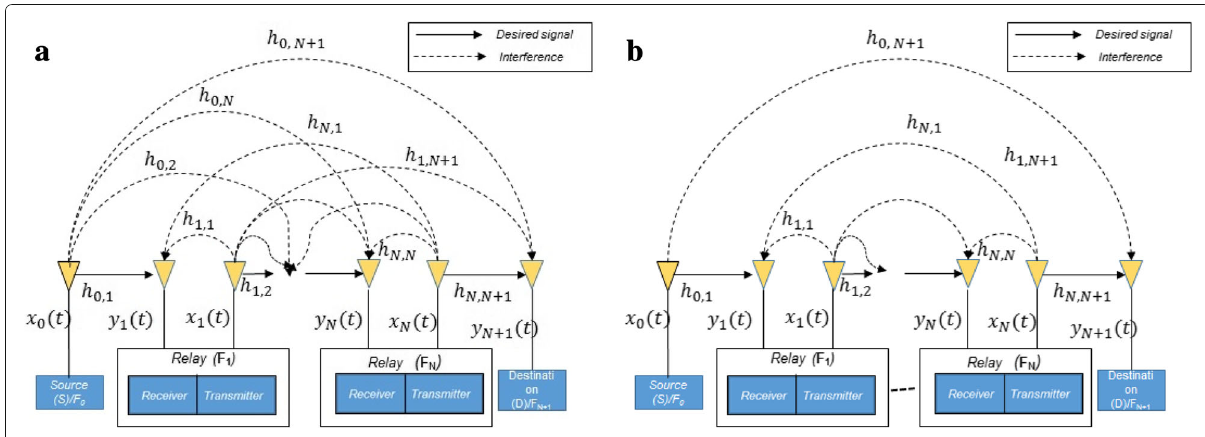
Fig. 1 Multi-hop system model. a FDR system. b Spectral efficient HDR system ( N is